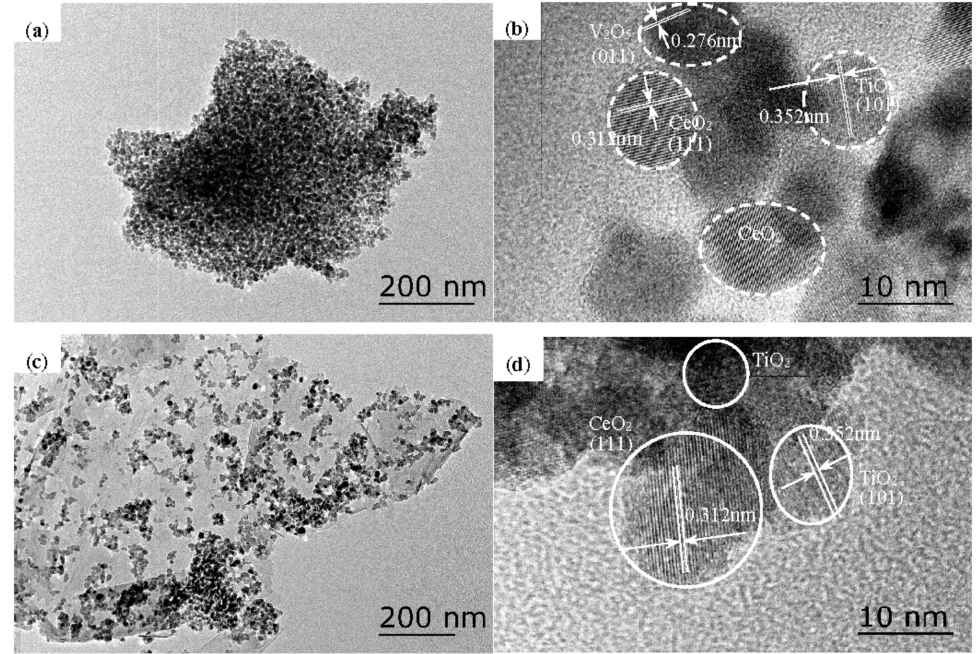
Figure 6. Transmission electron microscropy (TEM) images of catalysts: ( a , b ) Ce-V-Ti, ( c , d ) Ce-V-Ti / GO(0.7).